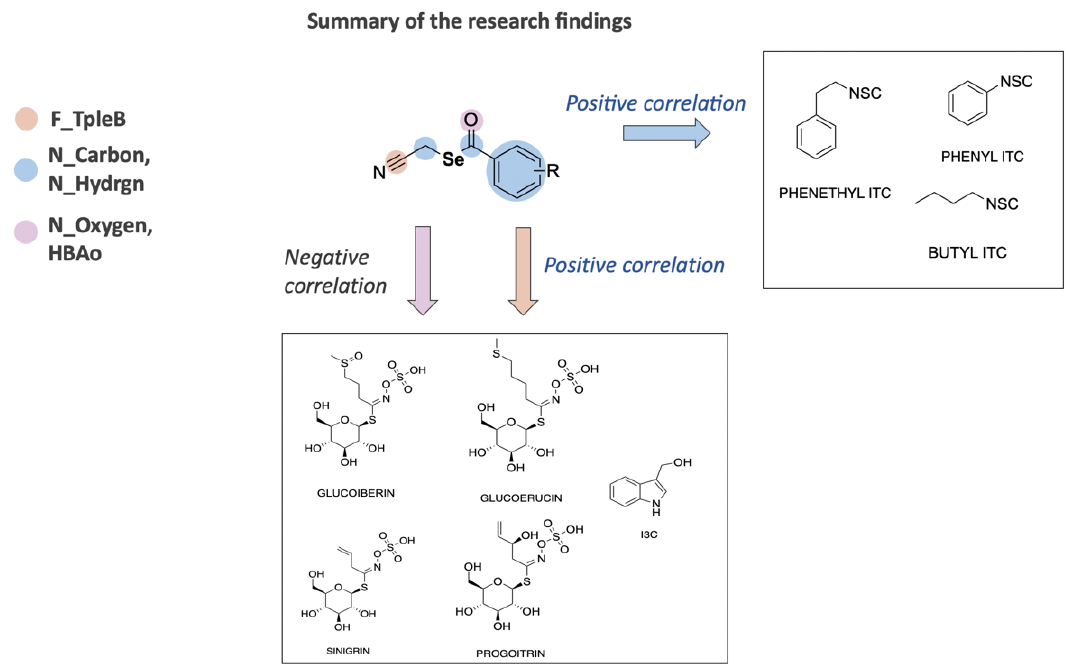
Figure 5. Summary of the main relationship regarding structure of organic selenium compounds and synthesis of different sulfur compounds.